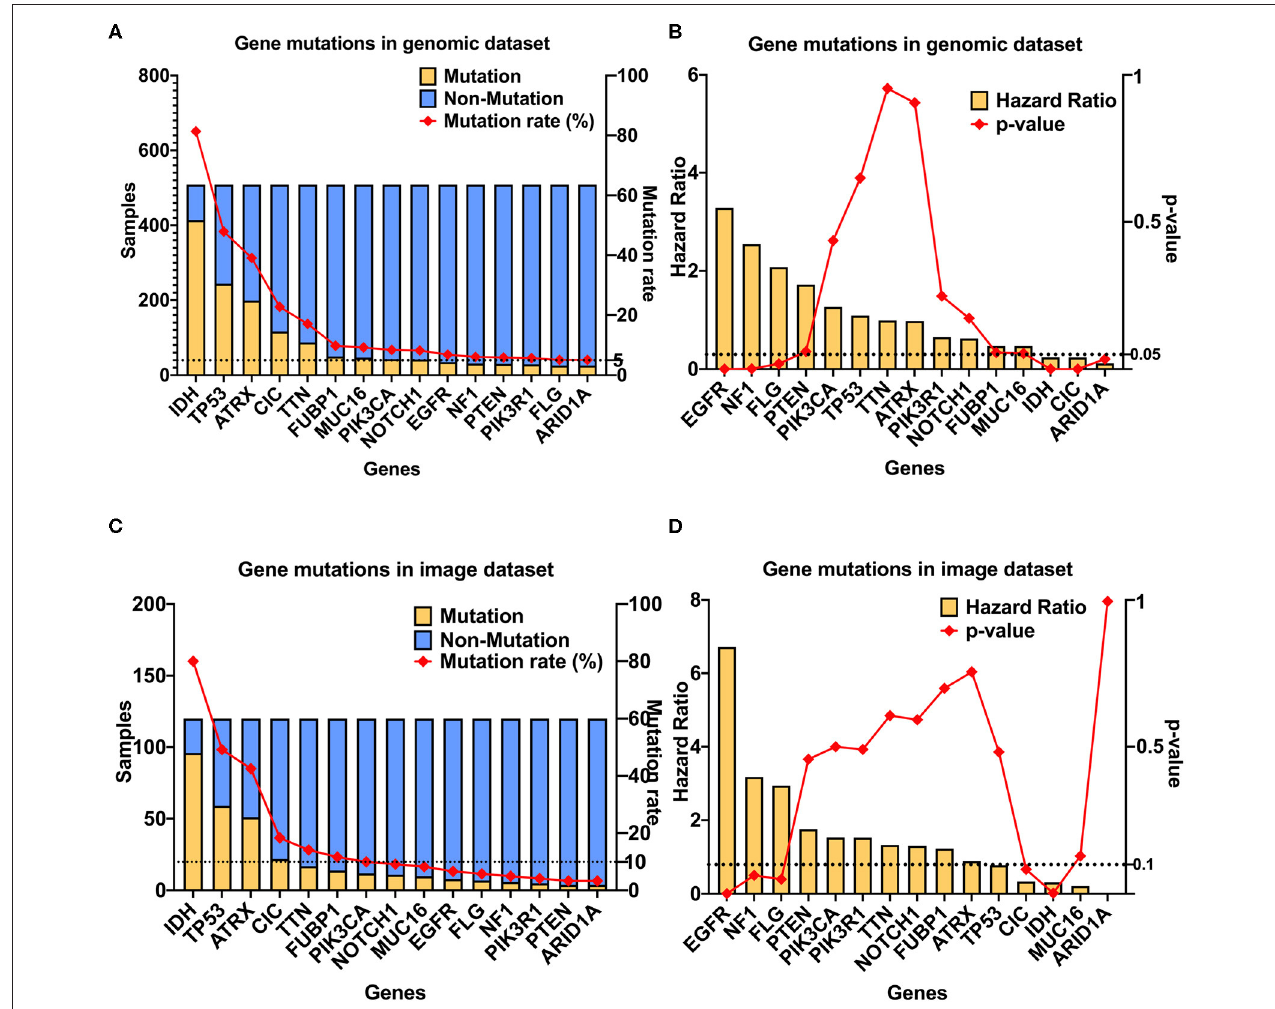
FIGURE 3 | CIC mutation has a high occurrence rate and association with survival in LGG. (A) CIC mutation rate in gliomas. GBM, GBM dataset from cBioPortal (TCGA Cell 2103); LGG (509), TCGA LGG dataset; LGG (120), from TCIA. (B) Gene mutations in the TCGA dataset ( n 509), 15 gene mutation rates are > 5%. = (C) Gene mutations in the TCIA image dataset ( n 120), 12 gene mutation rates are > 5%. (D) Multivariate Cox regression result of gene mutations in the genomic = dataset, age was included as covariate. Only seven gene mutations are significant.